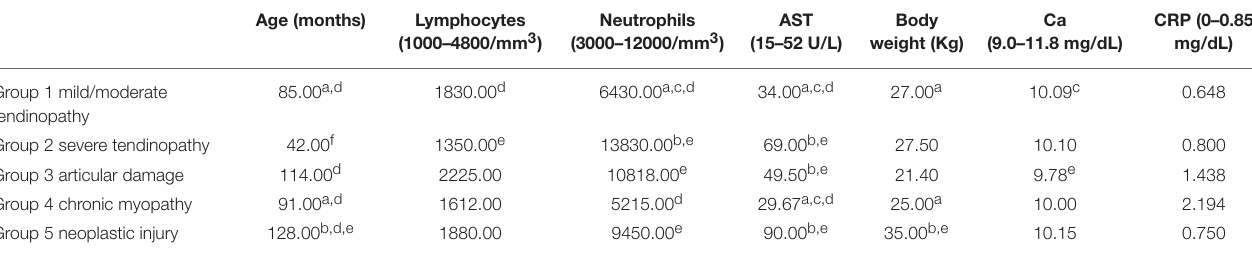
TABLE 2 | Median age, body weight, lymphocytem and neutrophil counts, Ca, AST, and CRP blood concentrations by